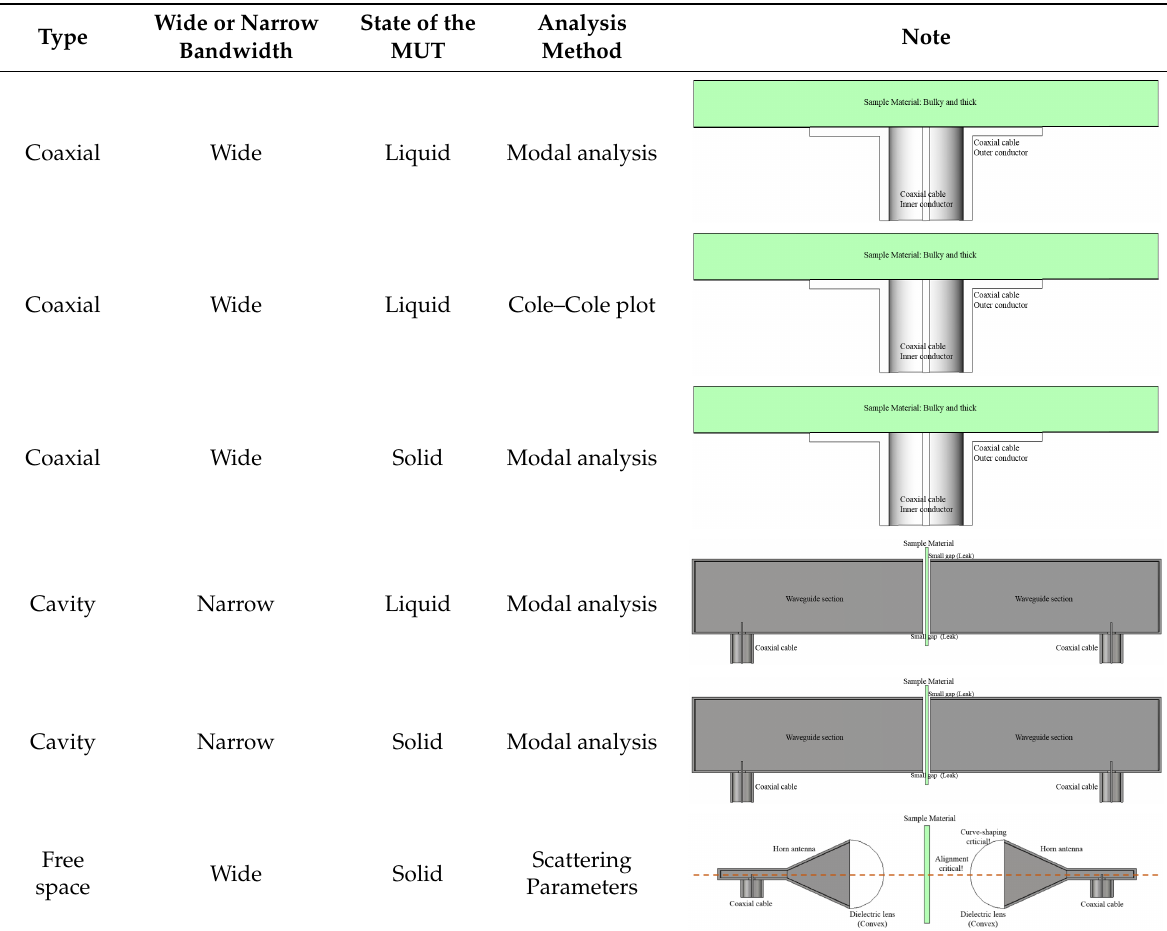
Figure 2. The most commonly used test setups to find the permittivity of a dielectric sample ( a ) Open-ended coaxial line ( b ) Embedding in a waveguide cavity ( c ) Line-of-sight link between horn antennas. 3. Design of the Sensor: The Resonator Array and the Meta-Surface The layers of the back−cover are of our concern, and the 3D geometry in Figure 1 is dissected along either of the principal axes into the side-view as the 2D information. Re- lated to the contact-type measurement configuration for a flat material as in Figure 2a, the 2D views of the back−cover’s original shape and COP film loaded without or with a meta- surface are comparatively shown as follows. Figure 3a shows the possible adaptation of the use of the open-ended coaxial cable in the permittivity extraction of layered media. The coaxial connector is slightly distant from the MUT, with the inner conductor sticking out, withdrawn from or ending at the plane of the flange, all of which are barely useful in this experiment. Imitating Figure 2a, the aperture of the coaxial cable touches the COP layer below the back−cover. In this case, the coaxial cable is not electrically compatible with the dielectric, and reflection severely oc- curs at the interface between the input transmission-line and the COP segment as shown in Figure 3b. There is another reflection from the mismatch between the COP film and the back−cover. The former reflection is mitigated by changing the direct contacting coaxial connector to a resonator array as mode transition from TEM to TM-mode as shown in Figure 3c,d. The latter reflection will be eased through the introduction of a meta-surface. As the initially suggested probe, sensitivity can be enhanced through Figure 3c. As a note, the equivalent circuit model is based on the transmission-line modelling each layer as the transmission-line segment of electrical length ( θ COP ) for the thickness and characteristic impedance ( Z COP ) for constitutive parameters [23–26]. As for Figure 3d, the voltage supply is connected to the cascading of transmission segments (( θ Sensor , Z Sensor ), ( θ COP , Z COP ) and ( θ BC , Z BC )) as the sensor, COP film and back−cover, respectively. There still exist reflected fields at the two interfaces. This reflection can be suppressed via structural impedance matching through the meta-surface denoted as Z MetaS in Figure 3e,f. This is called the fi- nally suggested probe, which requires a metal pattern to convert the COP film to work as a meta-material. Figure 3e reveals an extremely thin layer (2 oz thick) to bring down the reflection coefficient to the input or RF voltage supply as illustrated with return-signal arrows diminishing. The meta-material surface is used to match the impedance of material layers for the first time to our knowledge. It is expressed as the block remarked as Z MetaS . The lower S 11 (the reflection coefficient), the more improvement in accuracy for the per- mittivity sensing. When an MUT is given, its electrical characterization is carried out by